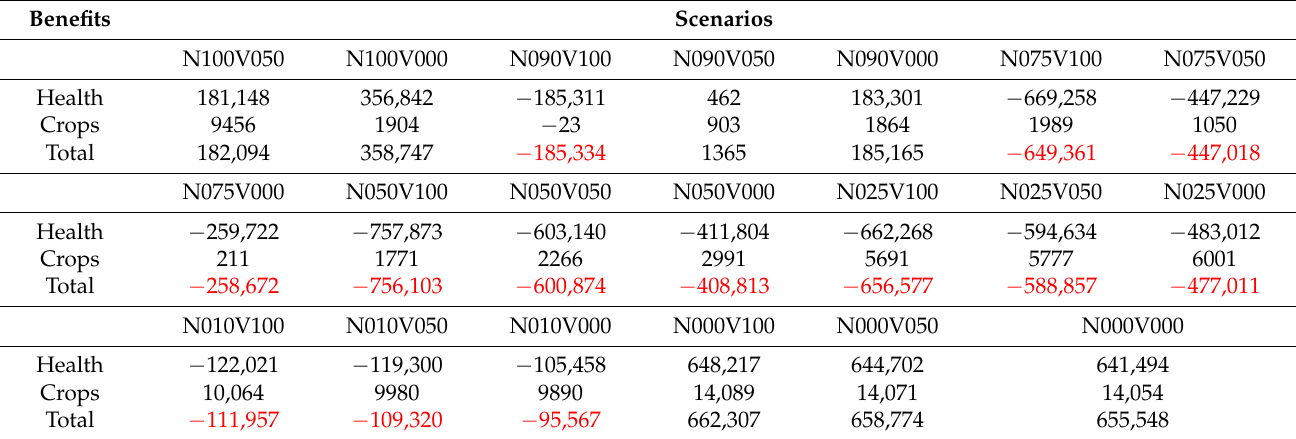
Table 3. Benefit analysis of the simulated scenarios. The benefit is measured as the monetary change in millions of yen between the base year and the reduction